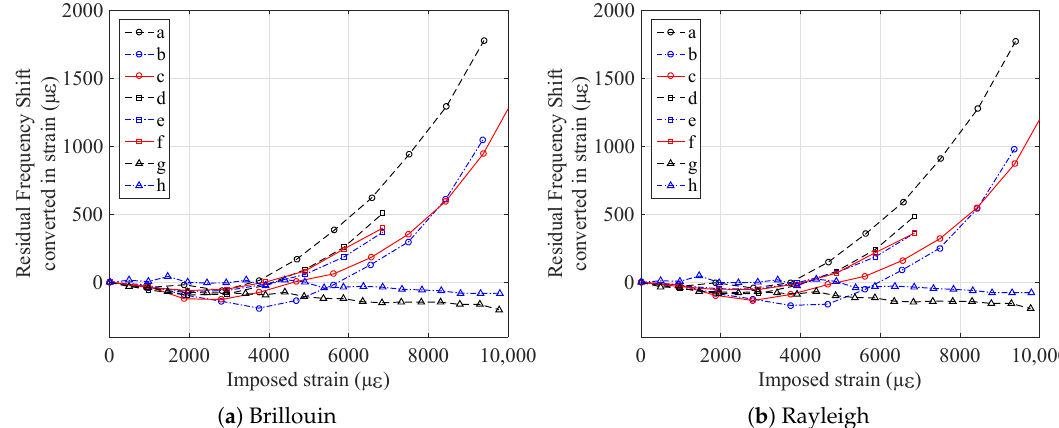
Figure 11. Residual strain of the samples after elongation (represented in the x axis) of all tested